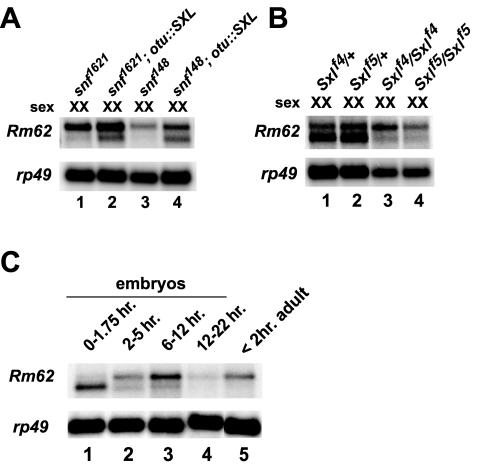
Germline SXL is necessary for expression of the female-specific Rm62 transcript.A. XX flies homozygous for the snf1621 or snf148 alleles, which disrupt SXL function specifically in the germline, do not express the female-specific Rm62 transcript (lanes 1 and 3). Expression of a Sxl cDNA in snf mutant backgrounds under the control of the otu promoter restores the synthesis of the female-specific Rm62 transcript (lanes 2 and 4). B. XX flies homozygous for the Sxlf4 or Sxlf5 alleles show a loss of the female-specific Rm62 transcript (lanes 3 and 4). C. The female-specific Rm62 transcript is maternally deposited, and is present only in mature ovaries.